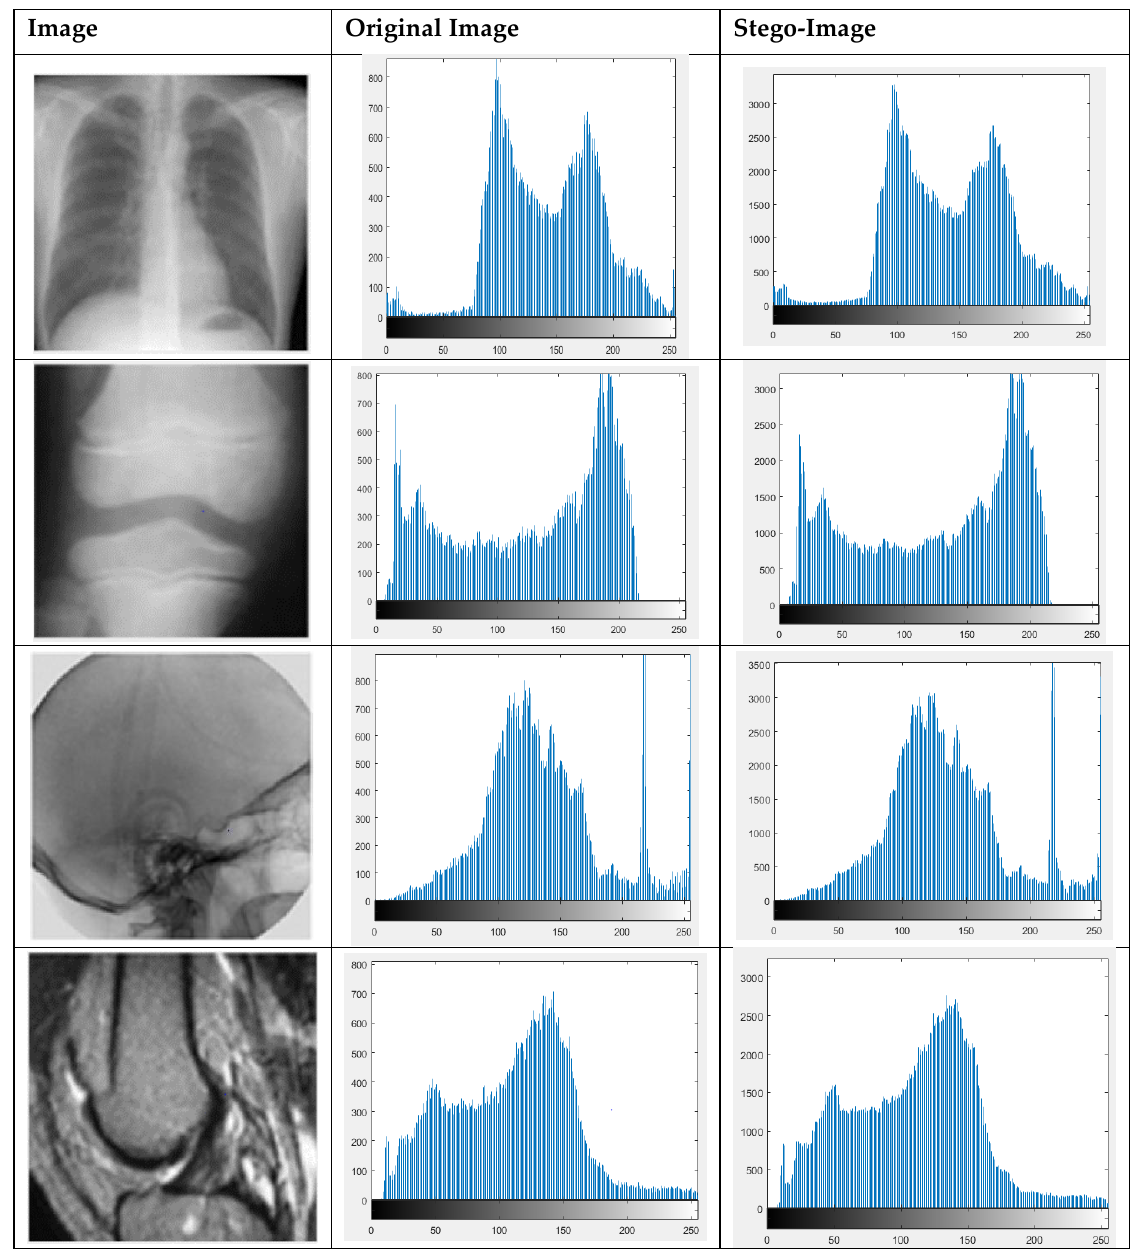
Figure 8. Histogram